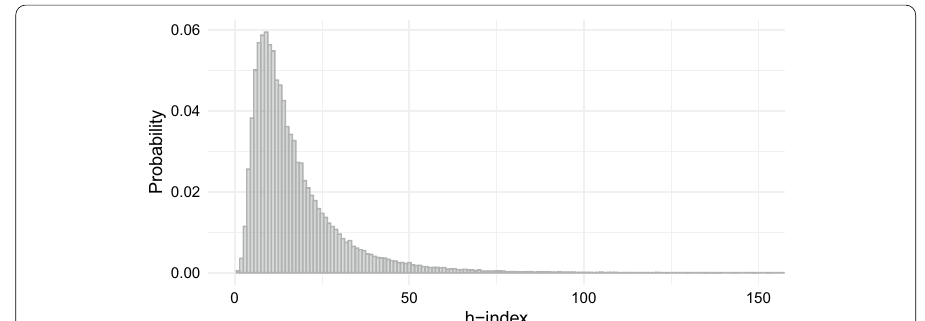
Fig. 4 Impact distribution. The average h-index for the authors in our dataset is 17.2